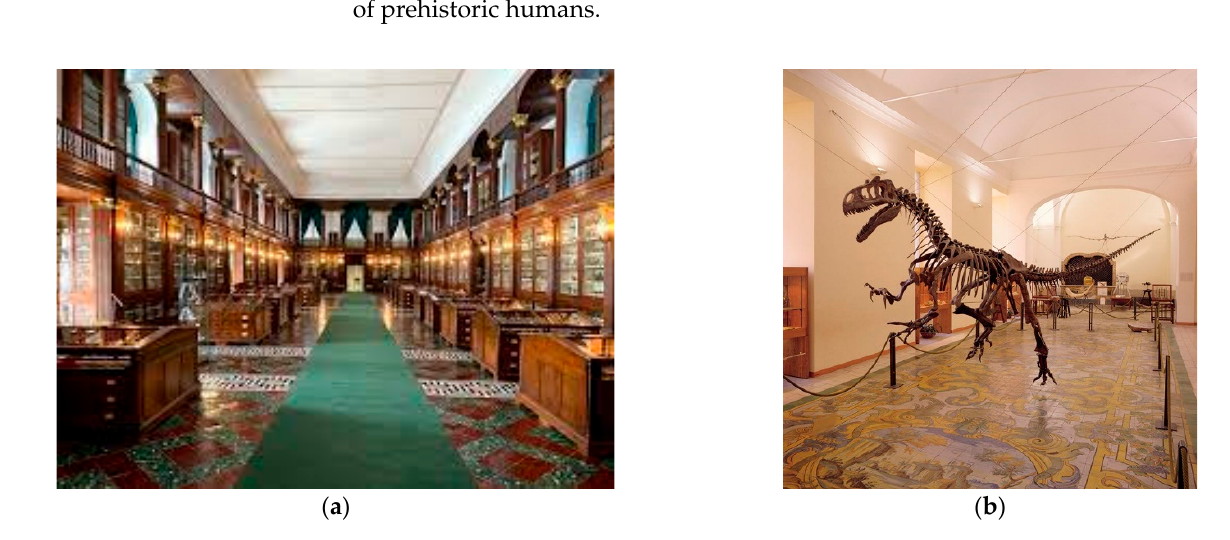
Figure 10. Images of the visit to some scientific institutions in Naples in 2018. ( a ) Museum of Mineralogy; ( b ) the “Dinosaur Room” of the Museum of Palaeontology (the reptile fossil, dating back 135 million years, comes from the USA).